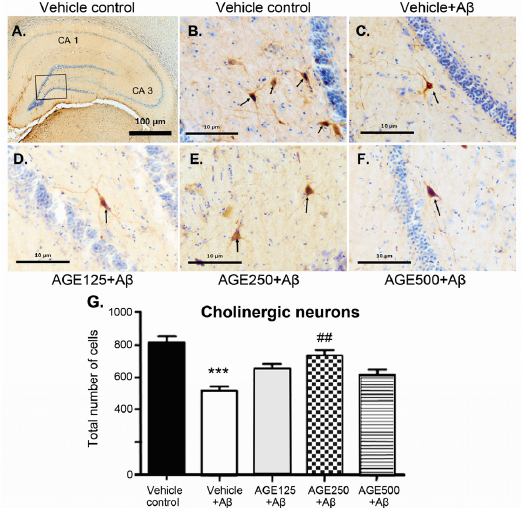
Figure 4. The neuroprotective effect of AGE (aged garlic extract) on cholinergic neurons in the hippocampal region of A β -induced rats. ( A – F ) represent the photomicrographs of brain section showing the distribution of cholinergic neurons by double staining of Nissl stain with cresyl violet and immunohistochemistry stained with polyclonal ChAT (choline acetyltransferase) antibodies in the vehicle control group ( A and B ), vehicle + A β ( C ), AGE125 + A β ( D ), AGE250 + A β ( E ) and AGE 500 + A β ( F ). ( G ) represents the number of ChAT neurons. The cholinergic neurons are indicated with arrows. Data are presented as mean ± S.E.M. ( n = 8), *** = significant differences from the vehicle control group at p < 0.001 and ## = significant differences from the vehicle + A β group at p < 0.01.